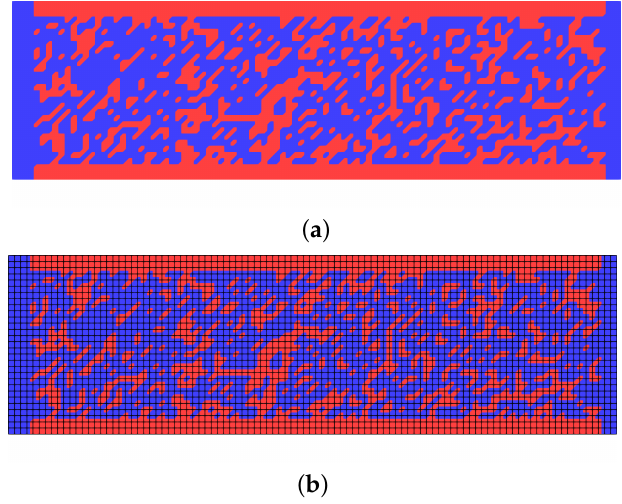
Figure 3. Example of a reconstructed “sandwich-like” porous catalytic medium: ( a ) computational domain without lattice grid; ( b ) computational domain with the lattice grid